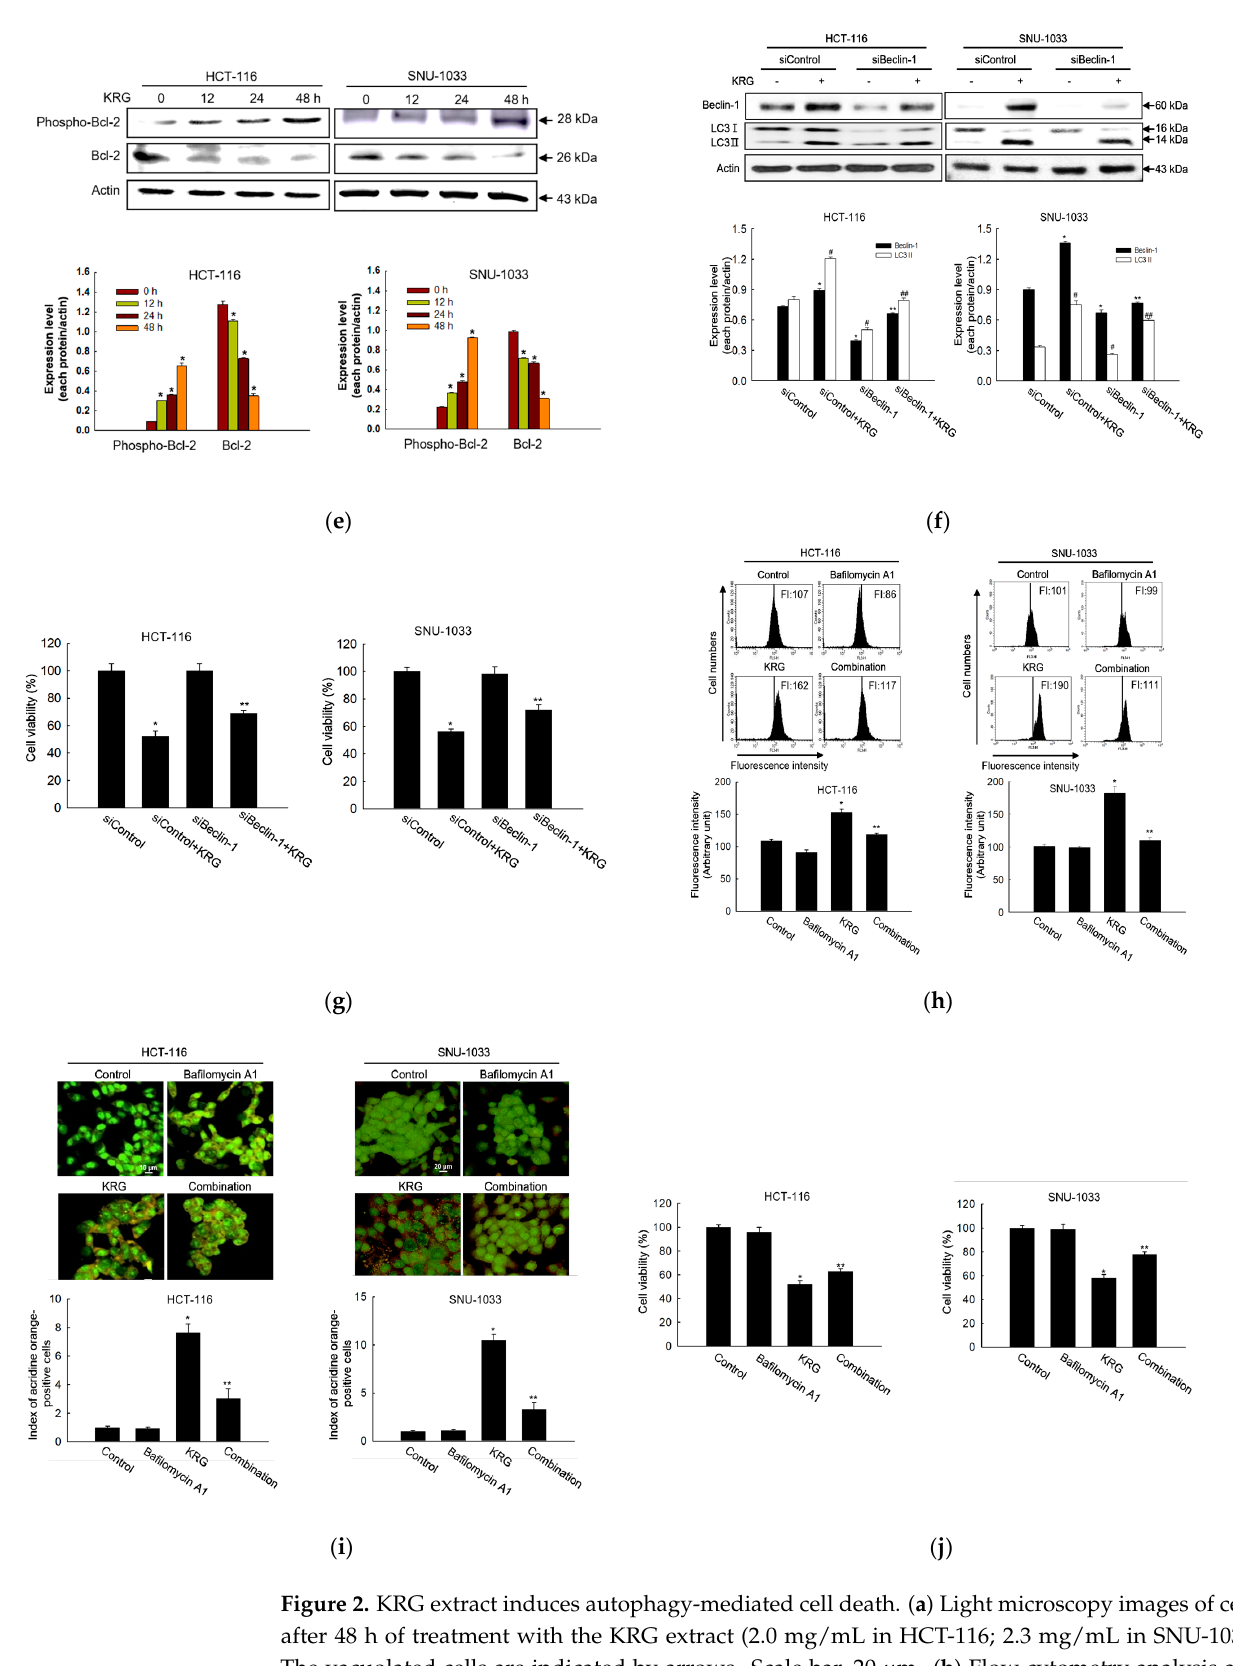
Figure 2. KRG extract induces autophagy-mediated cell death. ( a ) Light microscopy images of cells after 48 h of treatment with the KRG extract (2 mg/mL in HCT-116; 2.3 mg/mL in SNU-1033). The vacuolated cells are indicated by arrows. Scale bar, 20 μm. ( b ) Flow cytometry analysis and ( c ) flu- orescence microscopy analysis after staining of cells with acridine orange. * p < 0.05 vs. untreated control. ( d ) Fluorescence microscopy analysis of GFP-LC3-transfected cells. Scale bar, 40 μm. ( e ) Levels of Atg5, Beclin-1, LC3-I, and LC3-II in the KRG extract-treated cells were assessed using western blot analysis. * p < 0.05 vs. 0 h group. ( f ) After transfection of cells with siRNA against Beclin-1, the expression levels of beclin-1, LC3-I, and LC3-II were determined using western blot analysis. For Beclin-1 expression, * p < 0.05 vs. untreated siControl; ** p < 0.05 vs. the KRG extract- treated siControl cells. For LC3-II expression, # p < 0.05 vs. untreated siControl; ## p < 0.05 vs. the KRG extract-treated siControl cells. ( g ) Cell viability was measured using the MTT assay. * p < 0.05 vs. untreated siControl; ** p < 0.05 vs. the KRG extract-treated siControl cells. Cells were incubated with the KRG extract (2.0 mg/mL in HCT-116; 2.3 mg/mL in SNU-1033) without or with bafilomycin A1. Autophagy was detected using ( h ) flow cytometry and ( i ) fluorescence microscopy after staining the cells with acridine orange. Scale bar, 10 μm (HCT-116) and 20 μm (SNU-1033). * p < 0.05 vs. un- treated control; ** p < 0.05 vs. the KRG extract-treated cells. ( j ) Cell viability was evaluated using the MTT assay. * p < 0.05 vs. untreated control; ** p < 0.05 vs. the KRG extract-treated cells. 3.3. Apoptosis-Mediated Cell Death by KRG Extract The KRG extract induced apoptosis, as evidenced by the formation of apoptotic cells (Figure 3a), an increase in the number of sub-G 1 -phase cells (Figure 3b), and an increase in the levels of cleaved caspase-9, caspase-3, and PARP1 (Figure 3c) in colon cancer cells. In addition, the KRG extract-mediated apoptotic cell death was partially prevented by z-VAD- FMK, a pan-caspase inhibitor (Figure 3d). The KRG extract increased the phospho-Bcl-2 in a time-dependent manner with a concomitant decrease in the Bcl-2 level (Figure 3e). The interaction of Beclin-1 and Bcl-2 was decreased in the KRG extract-treated cells (Figure 3f).